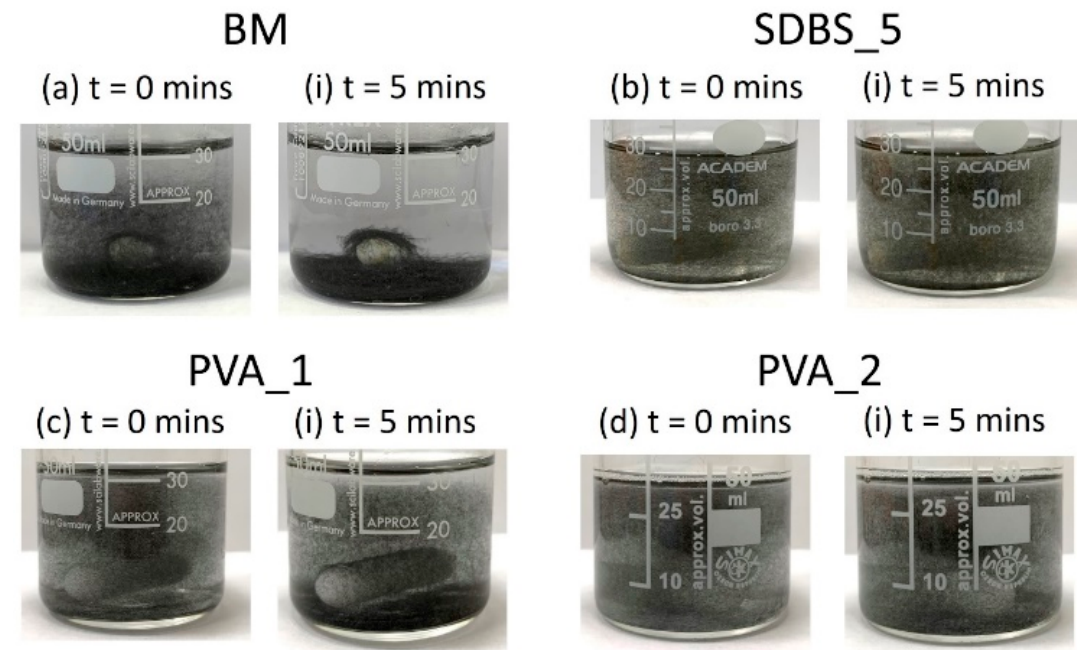
Figure 8. Dissolution experiment at t = 0 and t = 5 min for ( a ) BM ( b ) SDBS_5, compared to ( c ) PVA_1 and ( d ) PVA_2.